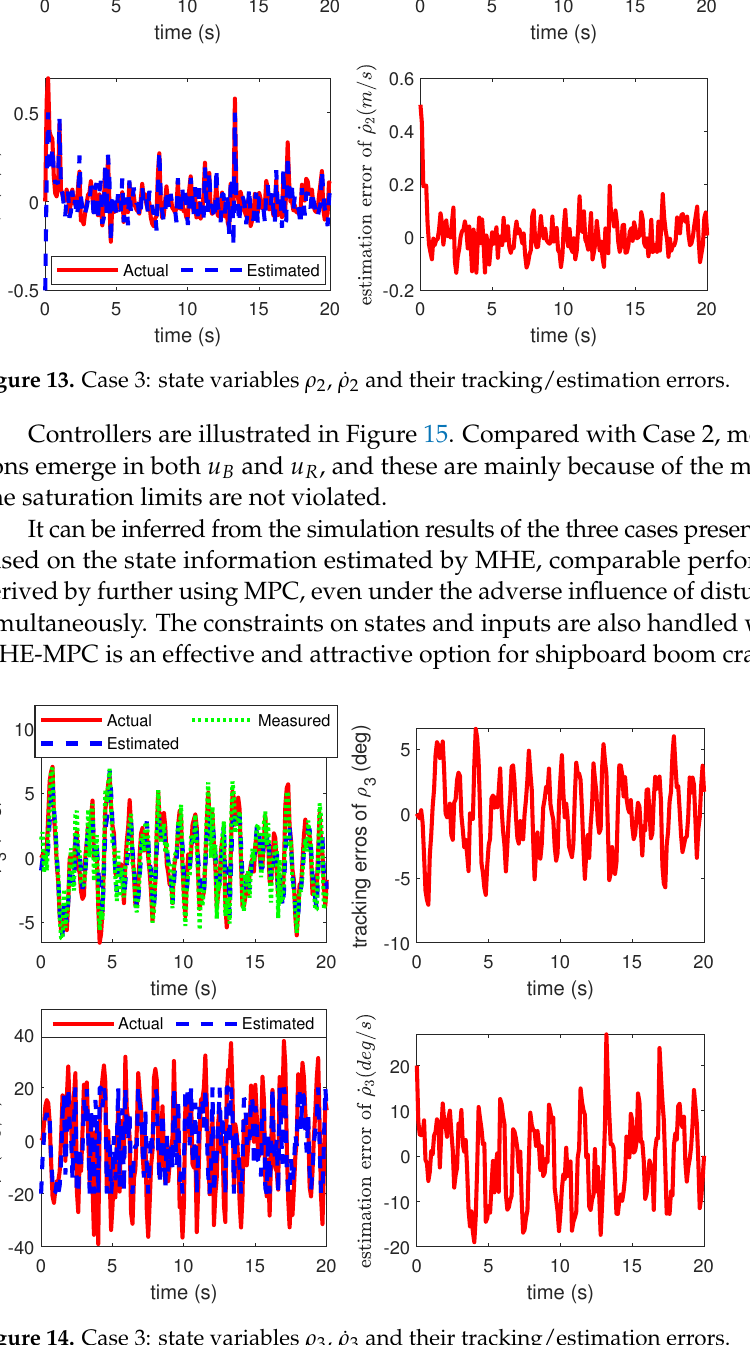
Figure 14. Case 3: state variables ρ 3 , ˙ ρ 3 and their tracking/estimation